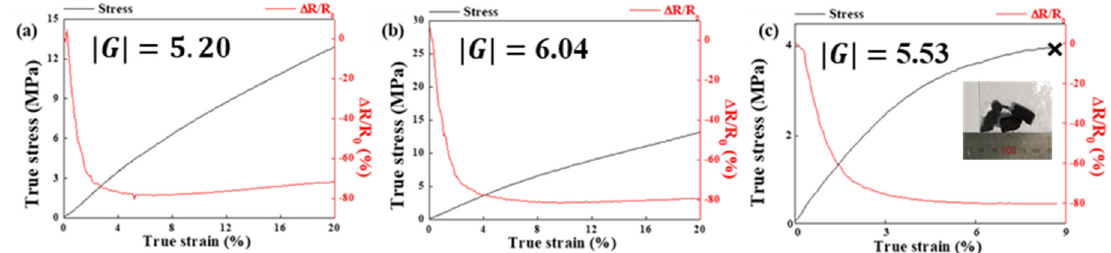
Figure 6. Normalized change of piezoresistive sensitivity and compressive stress versus strain for TPU/Cu/MWCNT composites at ( a ) 15 vol.%, ( b ) 17.5 vol.%, and ( c ) 20 vol.%.